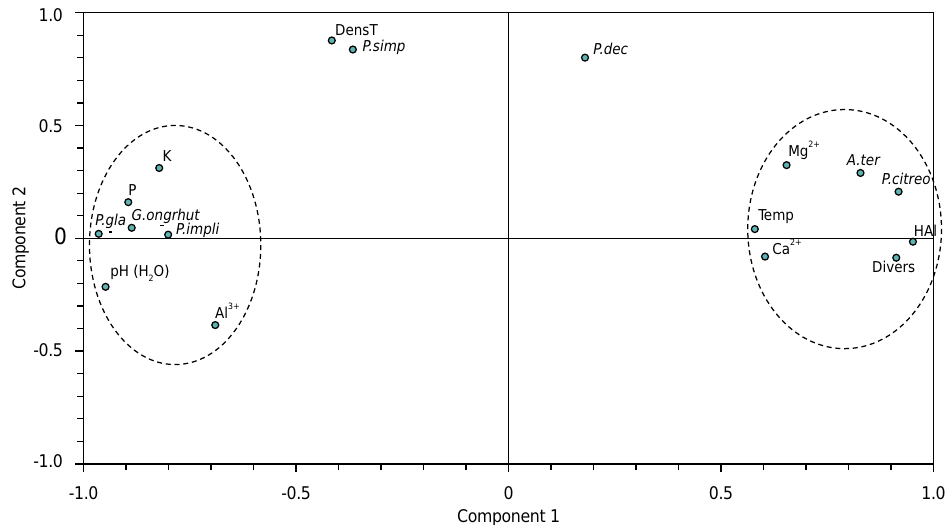
Figure 4. Two-dimensional projection of the Principal Component Analysis of soil samples from preserved and anthropized areas of the Parna Catimbau, Buíque, Pernambuco, Brazil. Factor 1 (Component 1) and Factor 2 (Component 2). P. gla: Penicillium glabrum ; G. ongrbut: Gongronella butleri ; P. impli: Penicillium implicatum ; P. simpli: P. simplicissimum ; Pdec: P. decumbens ; A ter: Aspergillus terreus ; P. cítreo: Penicillium citreonigrum